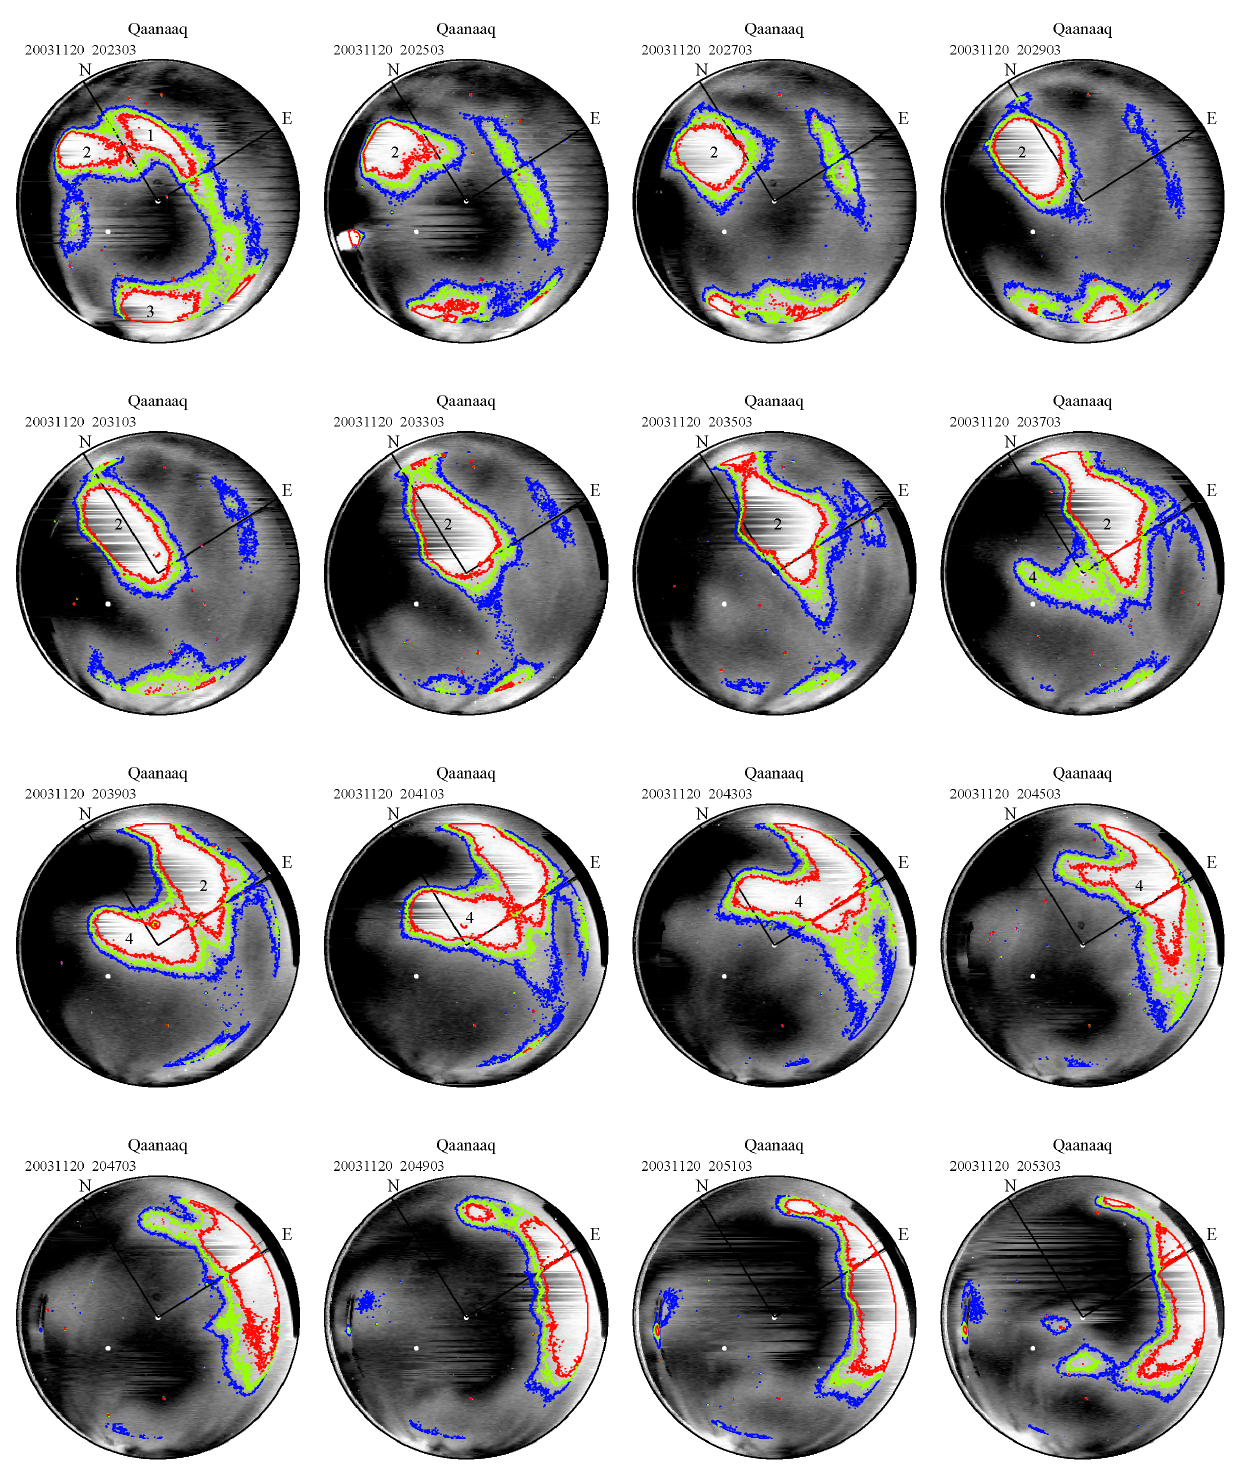
Figure 3. Sequence of images gathered at Qaanaaq, Greenland, between 20:23 and 20:53UT during the recovery phase of the magnetic storm of 20 November